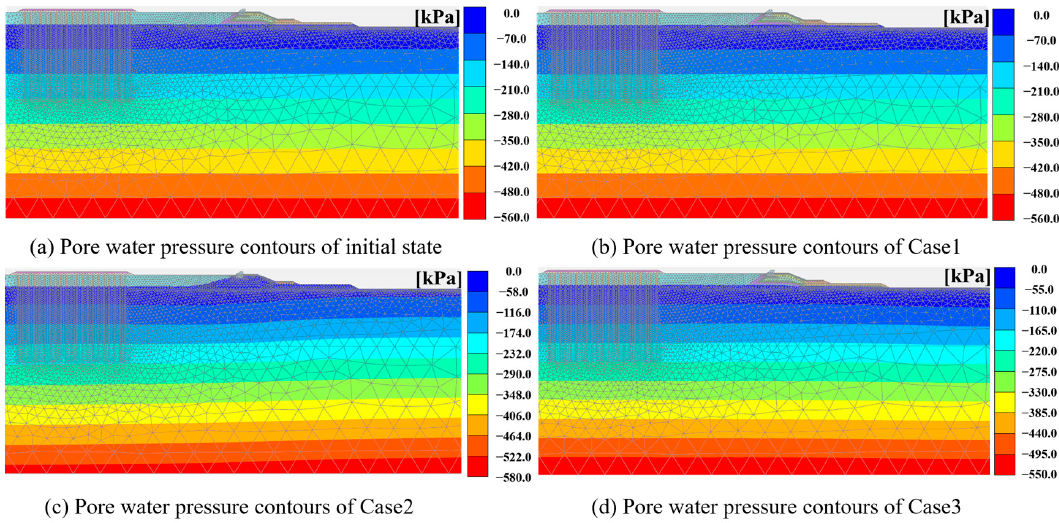
Figure 13. Contours of pore water pressure in the initial state and at the end of moment of the three cases.